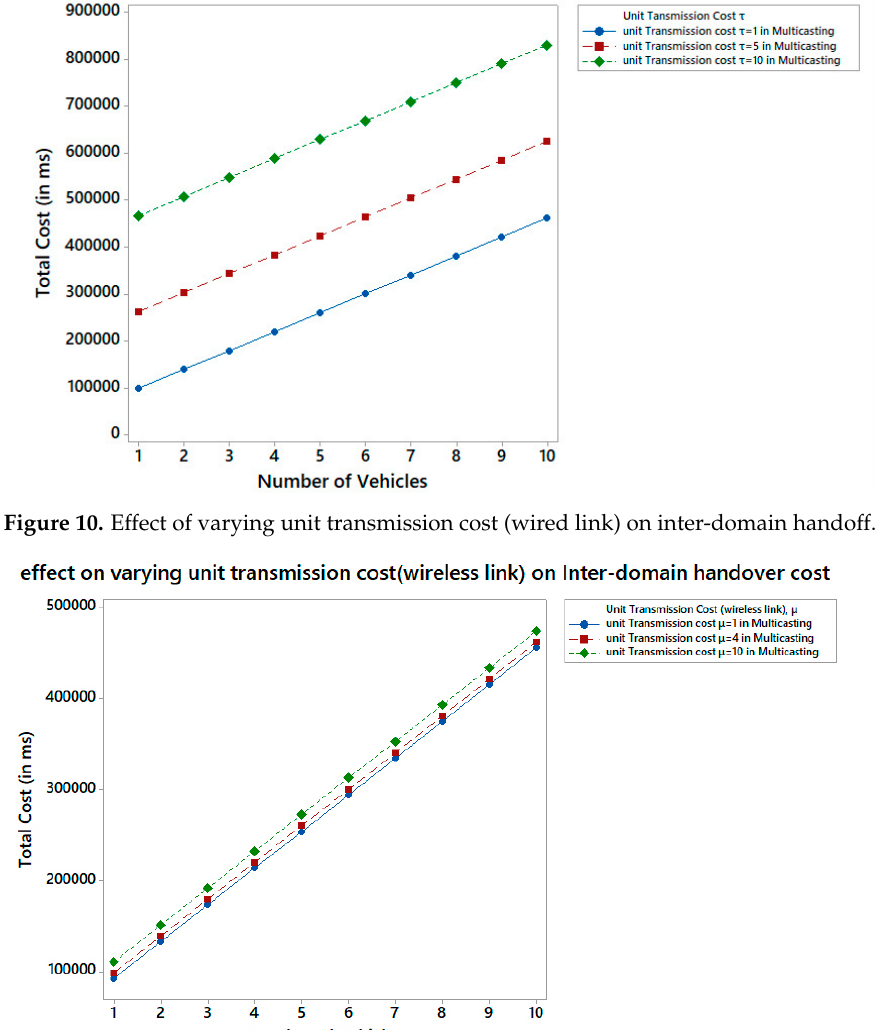
Figure 11. Effect of varying unit transmission cost (wireless link) on intra-domain handoff .